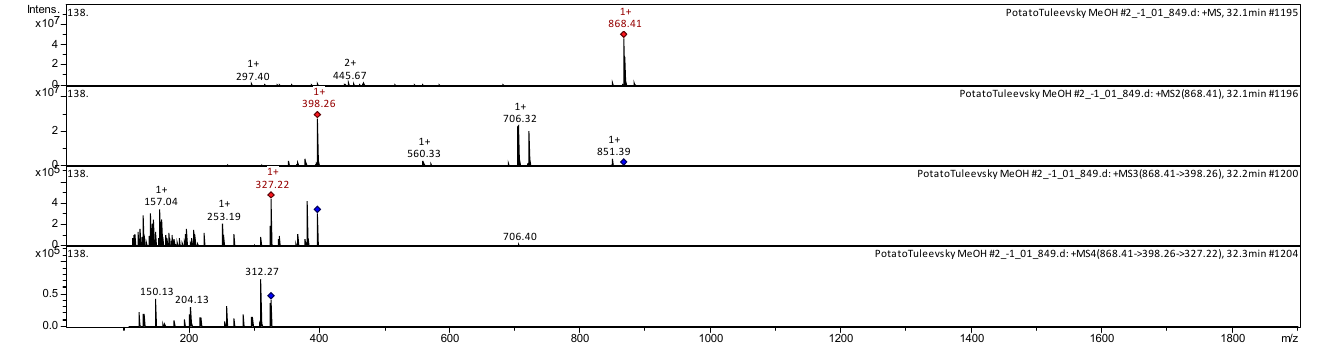
Figure 4. CID-spectrum of α -solanine from extracts of S. tuberosum (variety Tuleevsky), m / z 868.41.